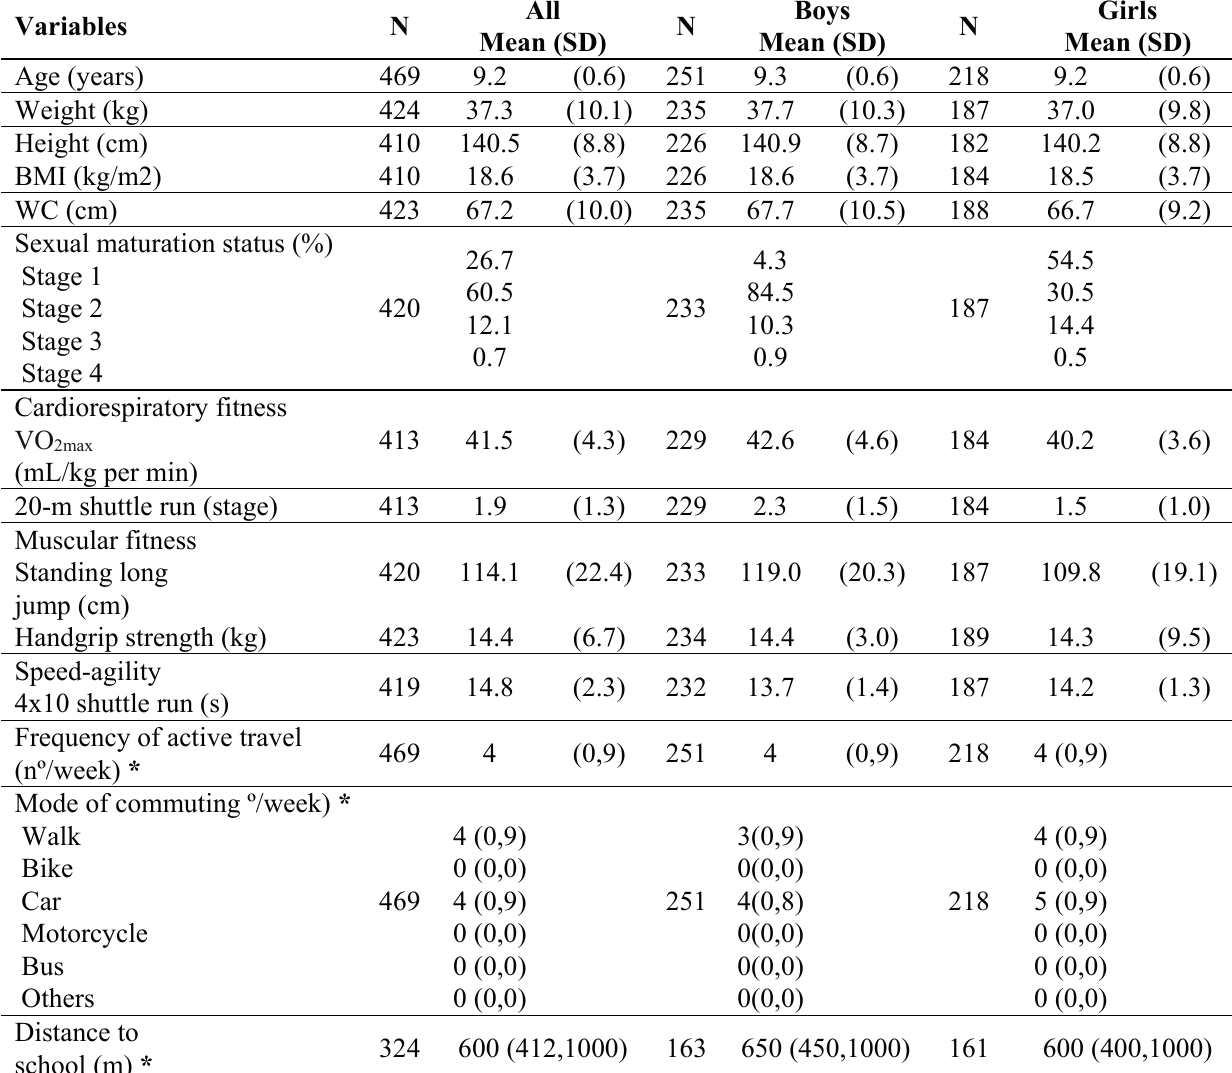
Table 1. Descriptive characteristics of the study sample stratified by